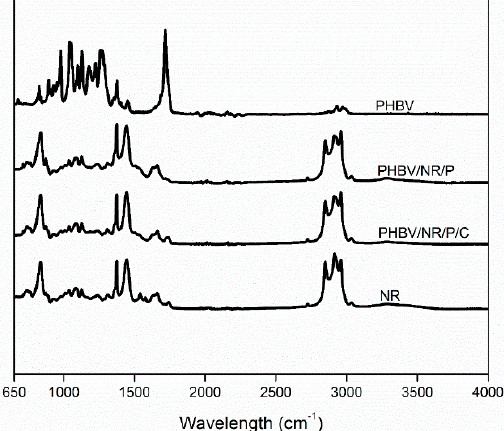
Figure 9. FTIR spectra of pristine PHBV, pristine NR, and gels from PHBV/NR/P and PHBV/NR/P/C blends obtained through chloroform extraction.